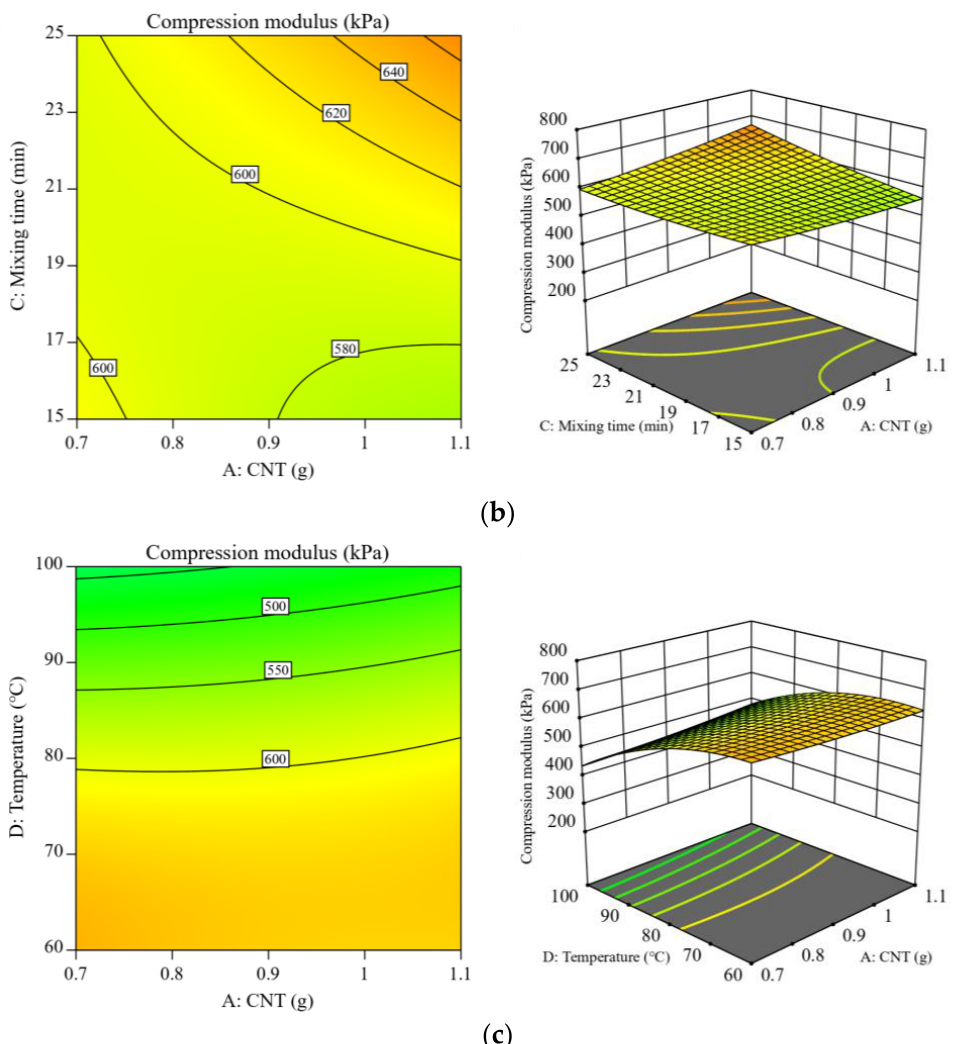
Figure 6. Studies of the relationship between the compressive modulus contour map and the three- dimensional response surface of CNT/GN-RTV composites with ( a ) CNT and GN content, ( b ) CNT content and mixing time, and ( c ) CNT content and curing temperature.